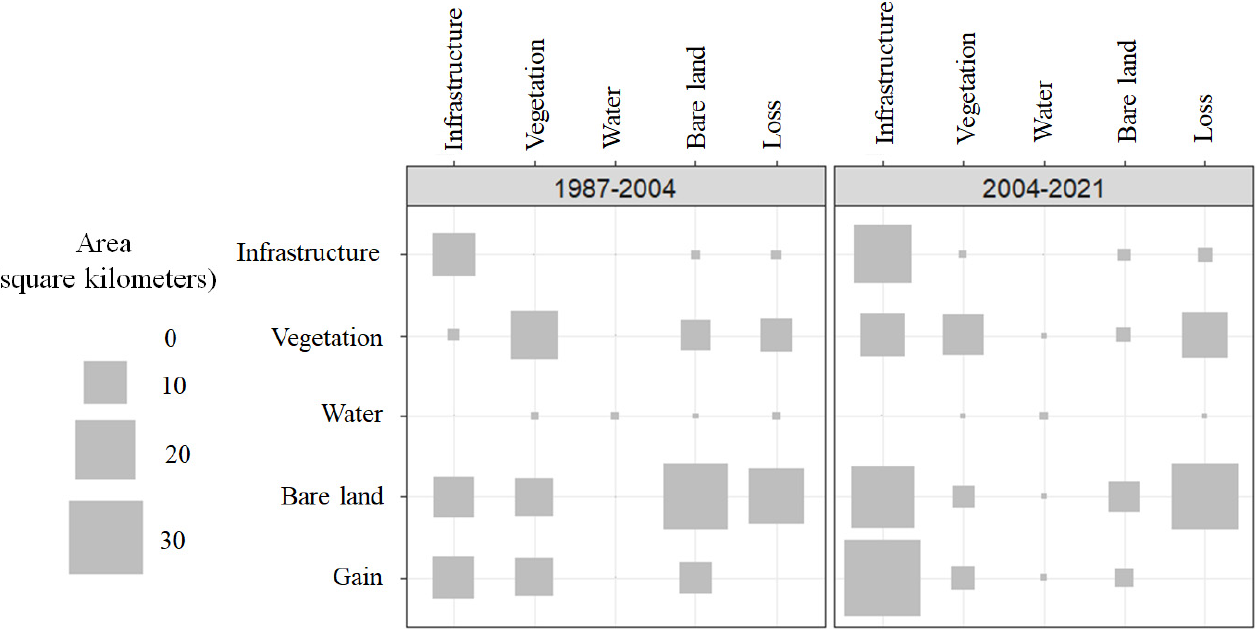
Figure 5. Transitional matrix during 1987 − 2004 and 2004 − 2021.